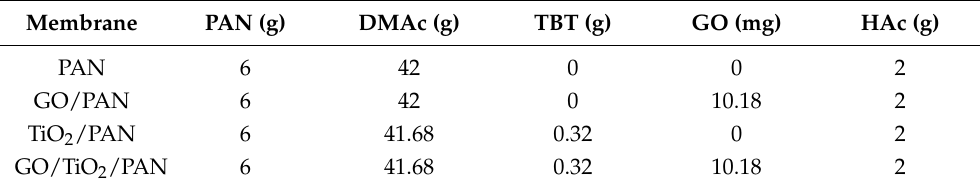
Table 1. Compositions of pure PAN membrane and the three kinds of PAN MMMs.